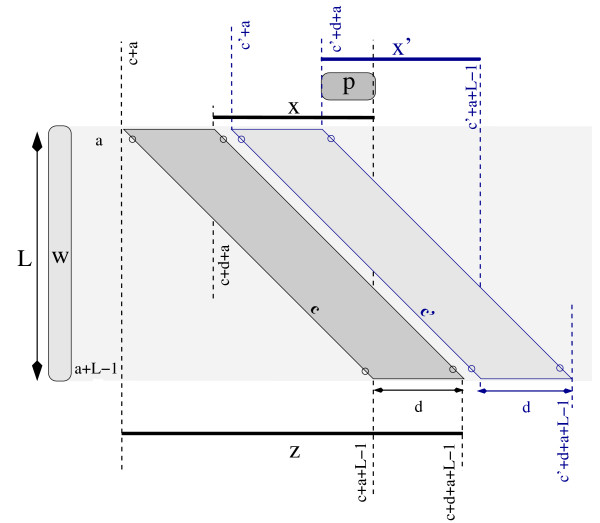
Detection of (L, d, r)-repeats and two overlapping parallelograms. Two parallelograms that overlap. The dark grey parallelogram in the figure detects q-hits between w = s[a, a + L - 1] and any word wk = s[i, j] with i ∈ [c + a, c + d + a] and j ∈ [c + a + L - 1, c + d + a + L - 1]. The word z = s[c + a, c + d + a + L - 1] of length L + d contains the word wk which in turn contains the word x = s[c + d + a, c + a + L - 1] of length L - d. Analogously for the light gray parallelogram, the word z' = s[c' + a, c' + d + a + L - 1] of length L + d contains a word w′k which in turn contains the word x' = s[c' + d + a, c' + a + L - 1] of length L - d. The words wk and w′k are not shown because their length is variable. They necessarily overlap because they both contain the word p = s[c' + d + a, c + a + L - 1], that is the overlap between x and x'.